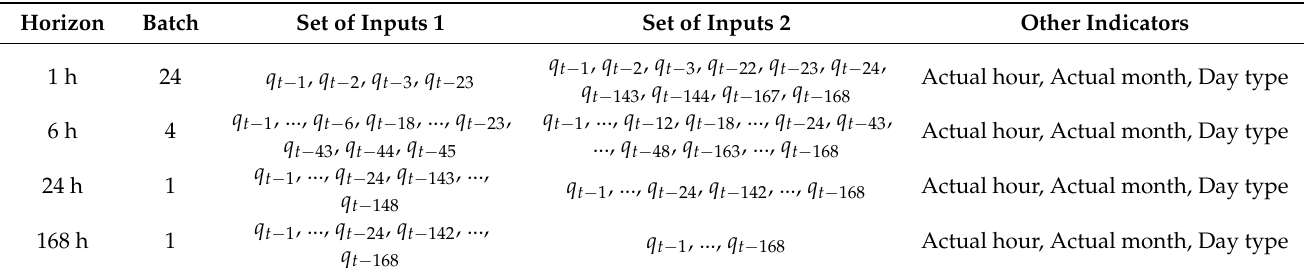
Table 1. Selected parameters for each forecasting horizon: batch size, past observations inputs and other inputs; q t represents the first consumption hourly value to be